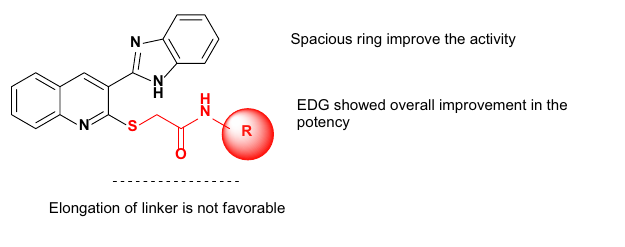
Figure 3. Summary of the SARs.